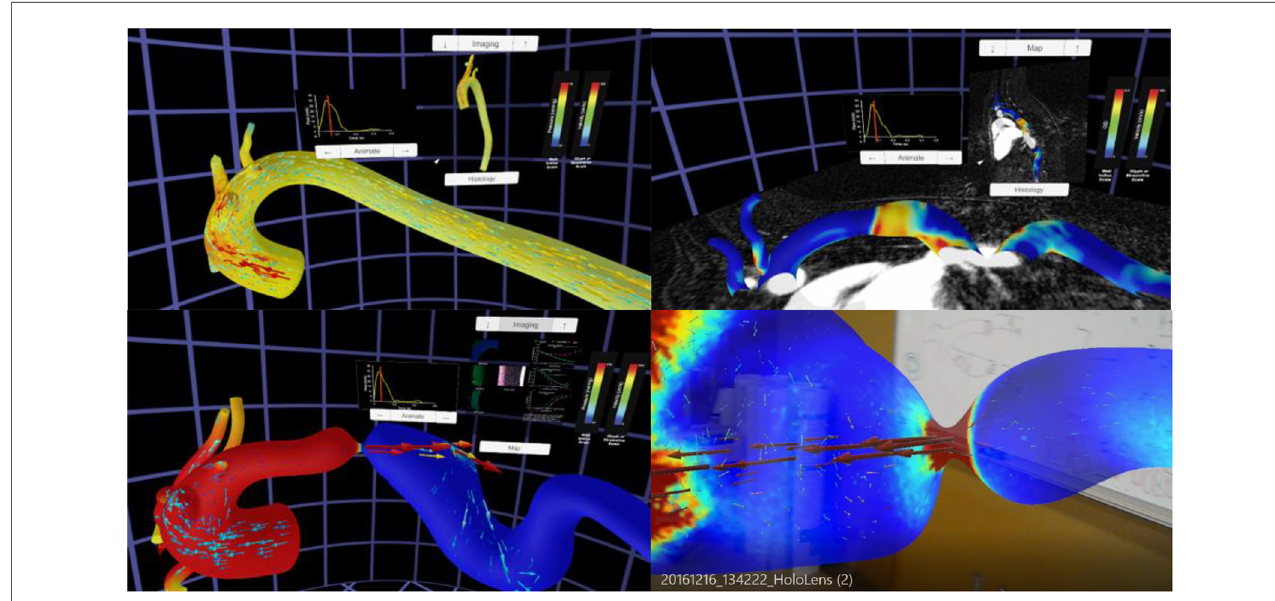
FIGURE 5 Screenshots from immersive viewing of a thoracic aorta data with application to coarctation of the aorta (CoA). Results shown using the Oculus Rift include those from a user simultaneously viewing instantaneous velocity vectors and pressure from a simulation in the Control group (top left), peak systolic pressure and velocity from a simulation in the CoA group (bottom left) together with local immunohistochemistry (i.e., structure) and myography (i.e., function) data, and oscillatory shear index and corresponding imaging data from a simulation of the Corrected group (top right). All results have a marker on associated in fl ow waveforms that indicate current time during the cardiac cycle. The current viewing location within the geometry and legends for each index are also present in each panel shown. The bottom right image shows a HoloLens after processing data from this application through the work fl ow and viewing in augmented reality within a research laboratory